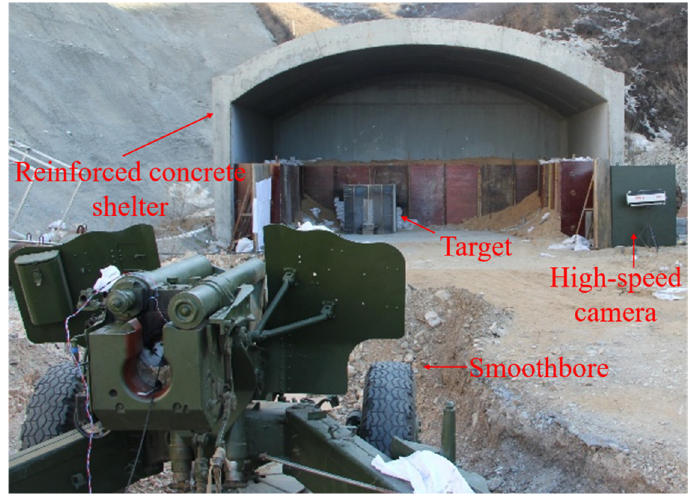
Figure 8. The layout of experiment site.